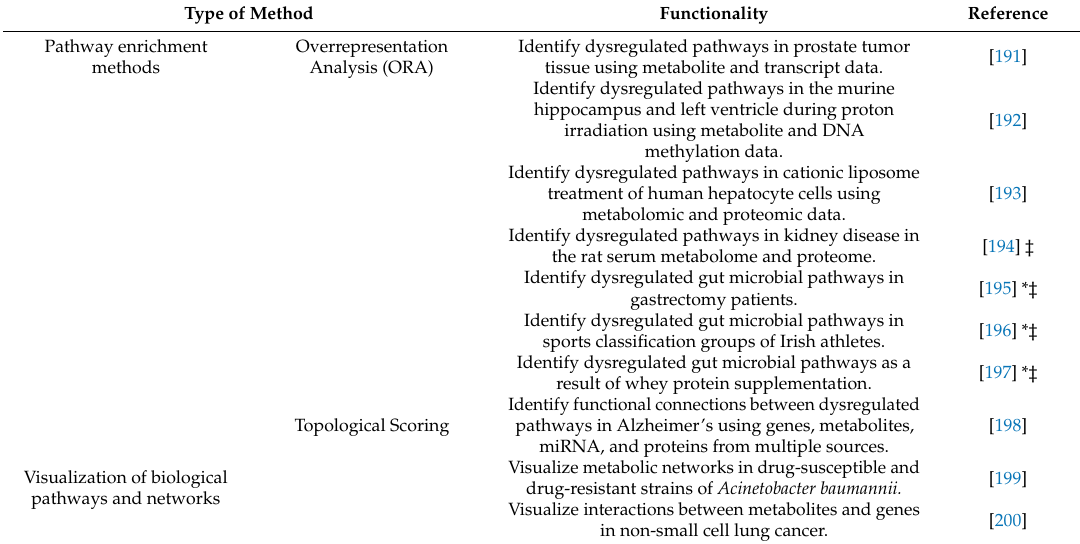
Table 4. Multi-omics applications using biological or visual interpretation